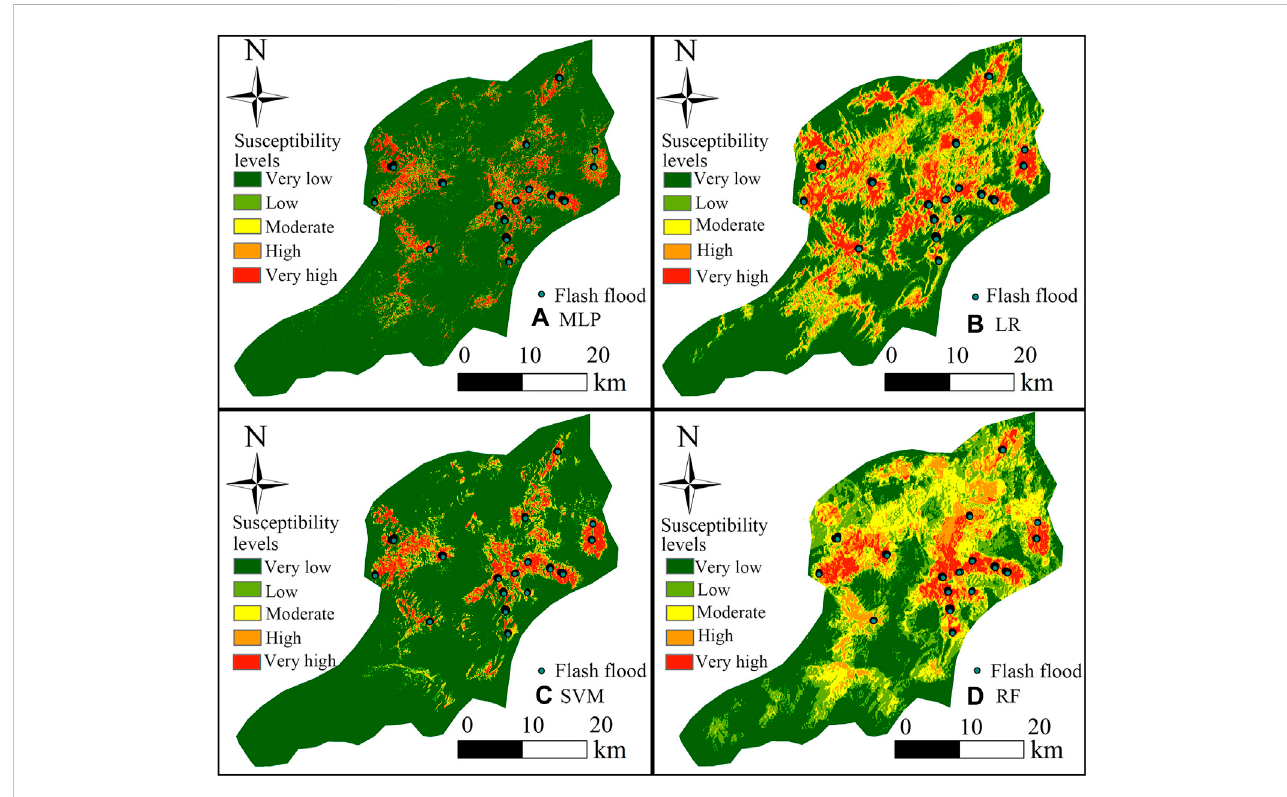
FIGURE 5 Flash fl ood susceptibility diagram of each model: (A) MLP, (B) LR, (C) SVM, (D) RF.